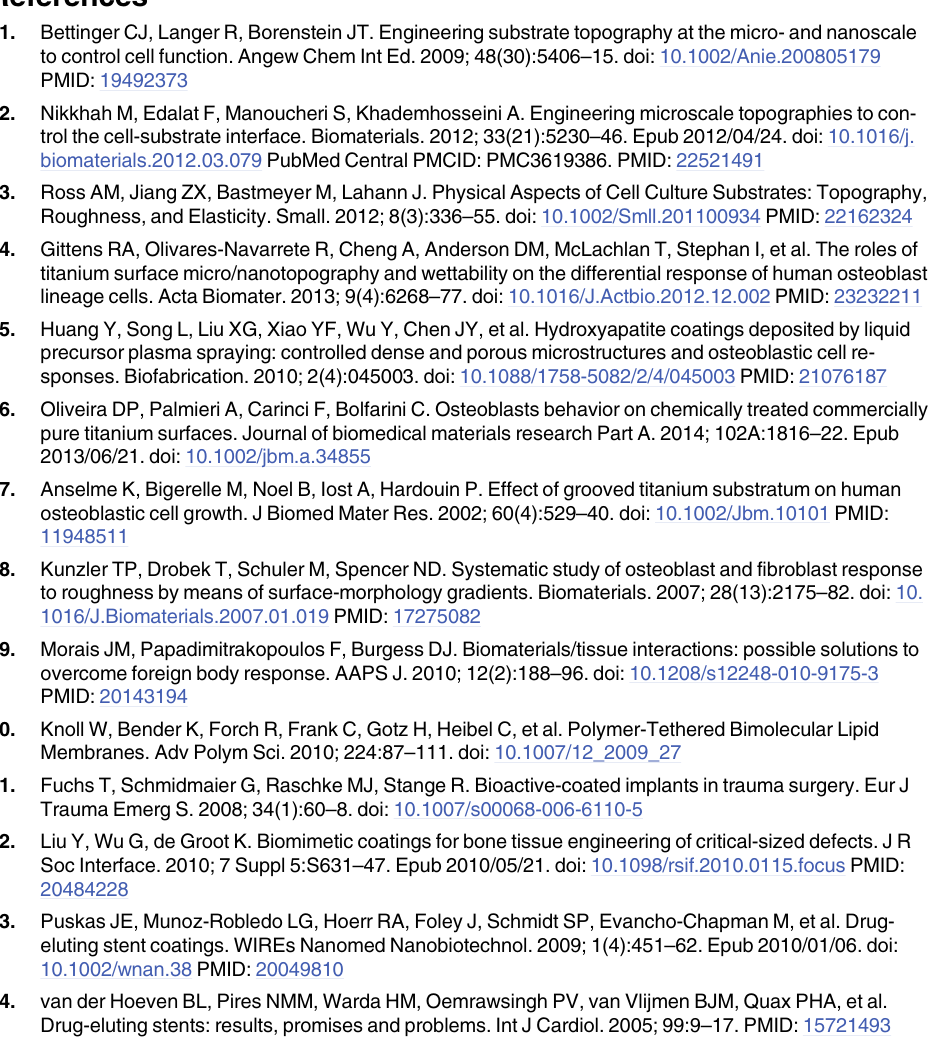
S1 Table. P value comparison of deposited droplet diameters obtained from different ele- trospraying modes represented in Fig